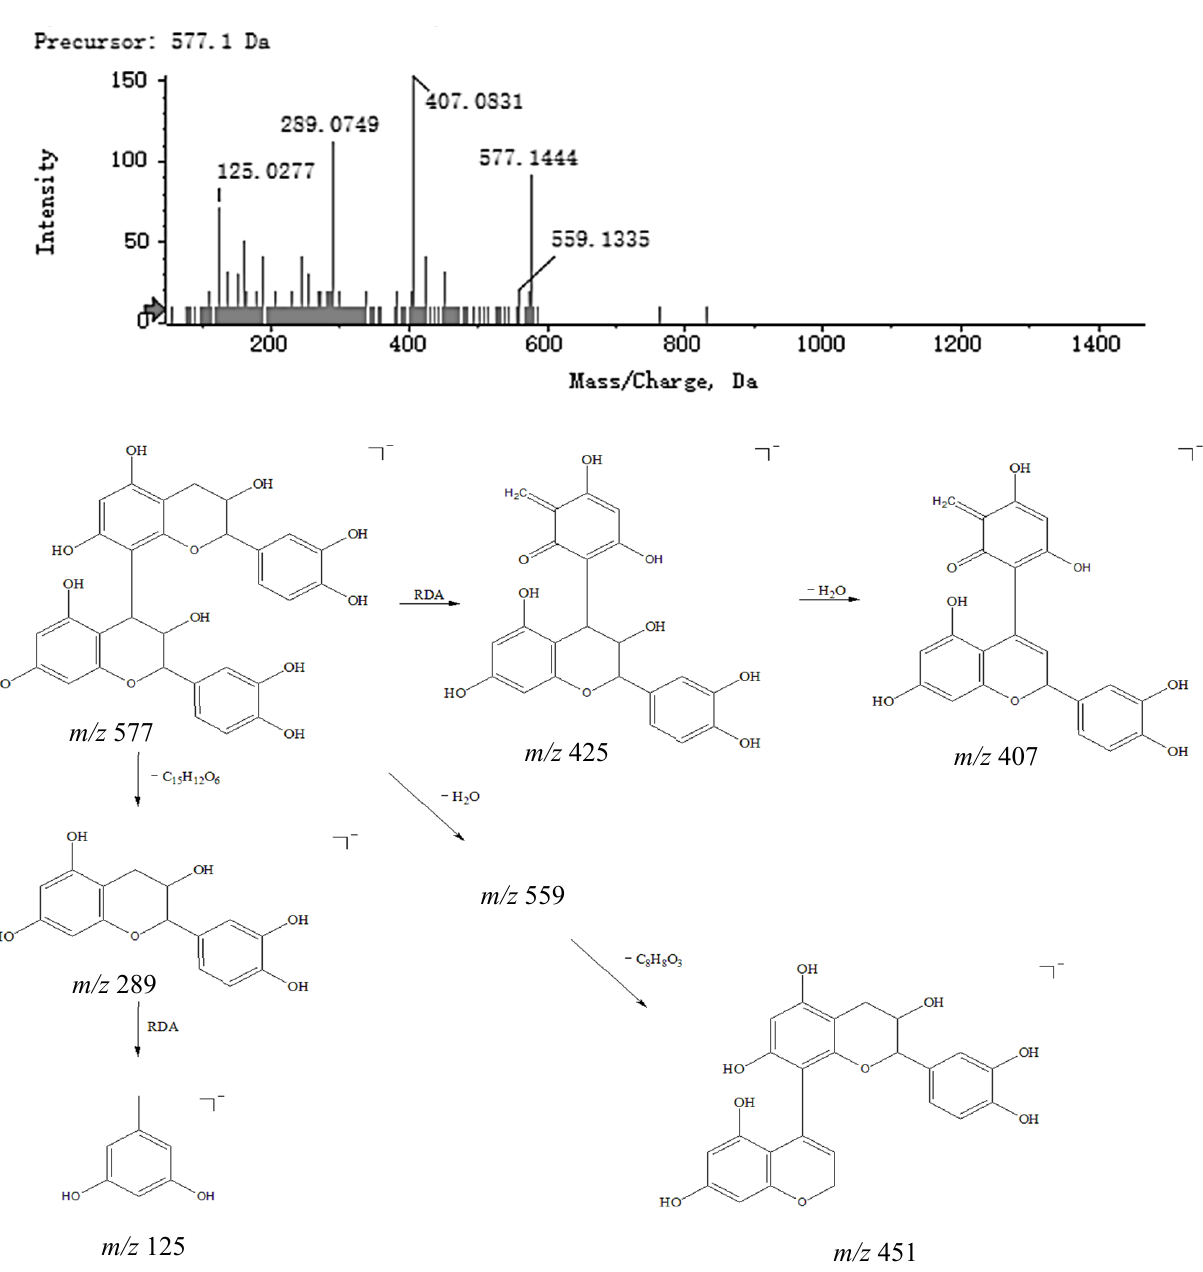
Figure 6. MS 2 spectra of procyanidin B1 and speculated fragmentation pathways.